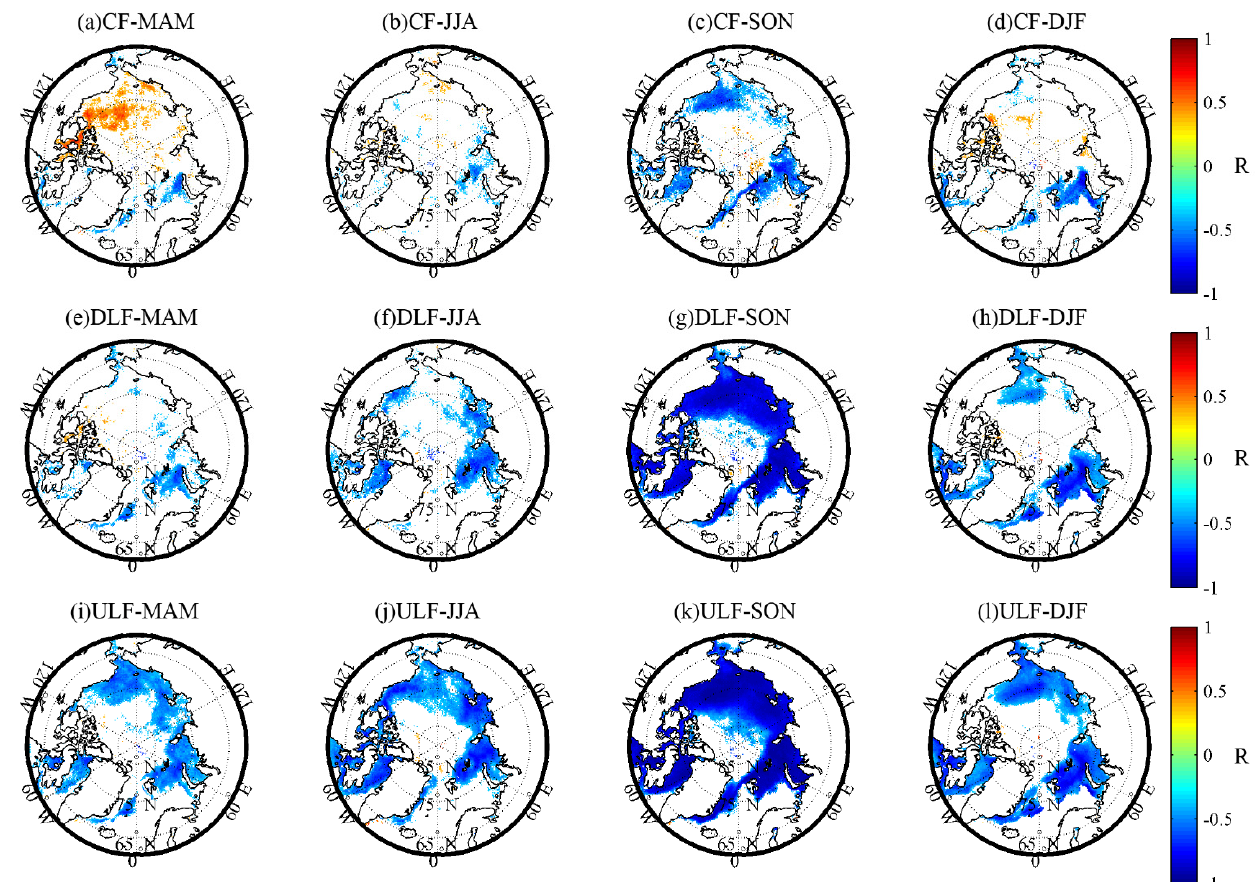
Figure 8. Seasonal distributions of Pearson’s correlation coefficient R (with p < 0.05) between the autumn SIC and ( a – d ) CF, ( e – h ) DLF, ( i – l ) ULF over the seas in Arctic (60°~90°N) from 1987 to 2019 at 04:00 LST. ( a , e , i ) MAM; ( b , f , j ) JJA; ( c , g , k ) SON; ( d , h , l ) DJF.